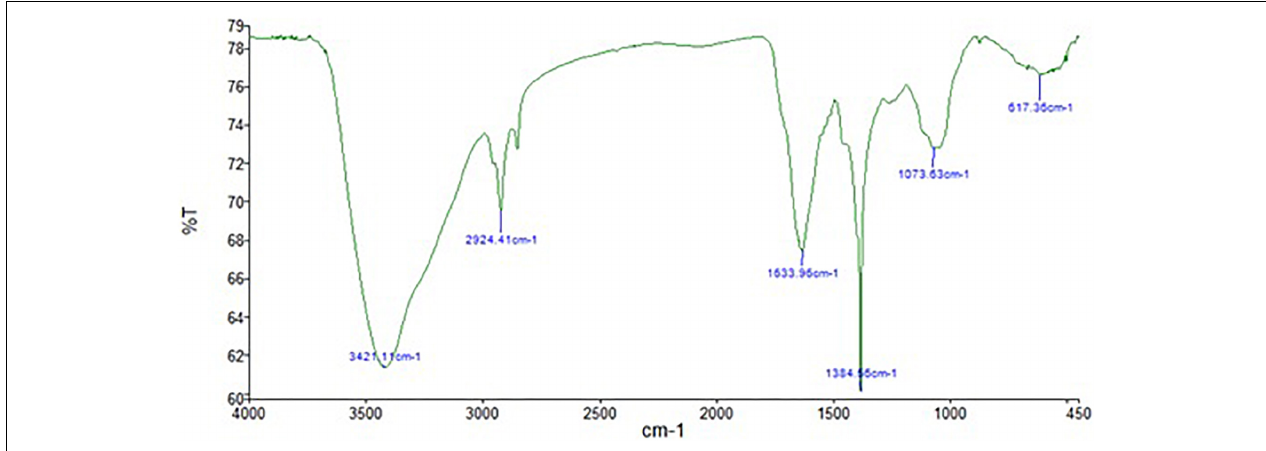
FIGURE 9 | FTIR spectrum of AgNPs obtained from A. terreus